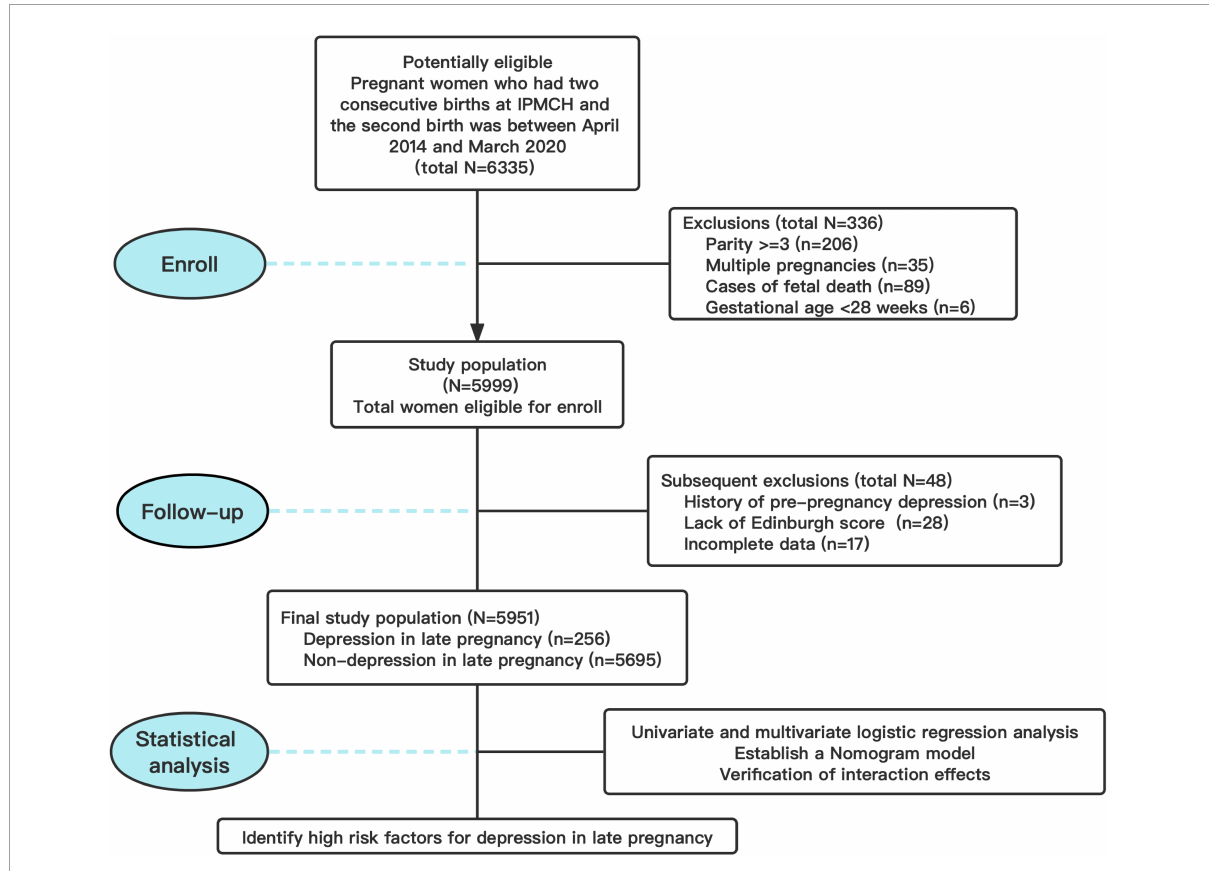
FIGURE1 Flow chart illustrating study population selection and data availability.